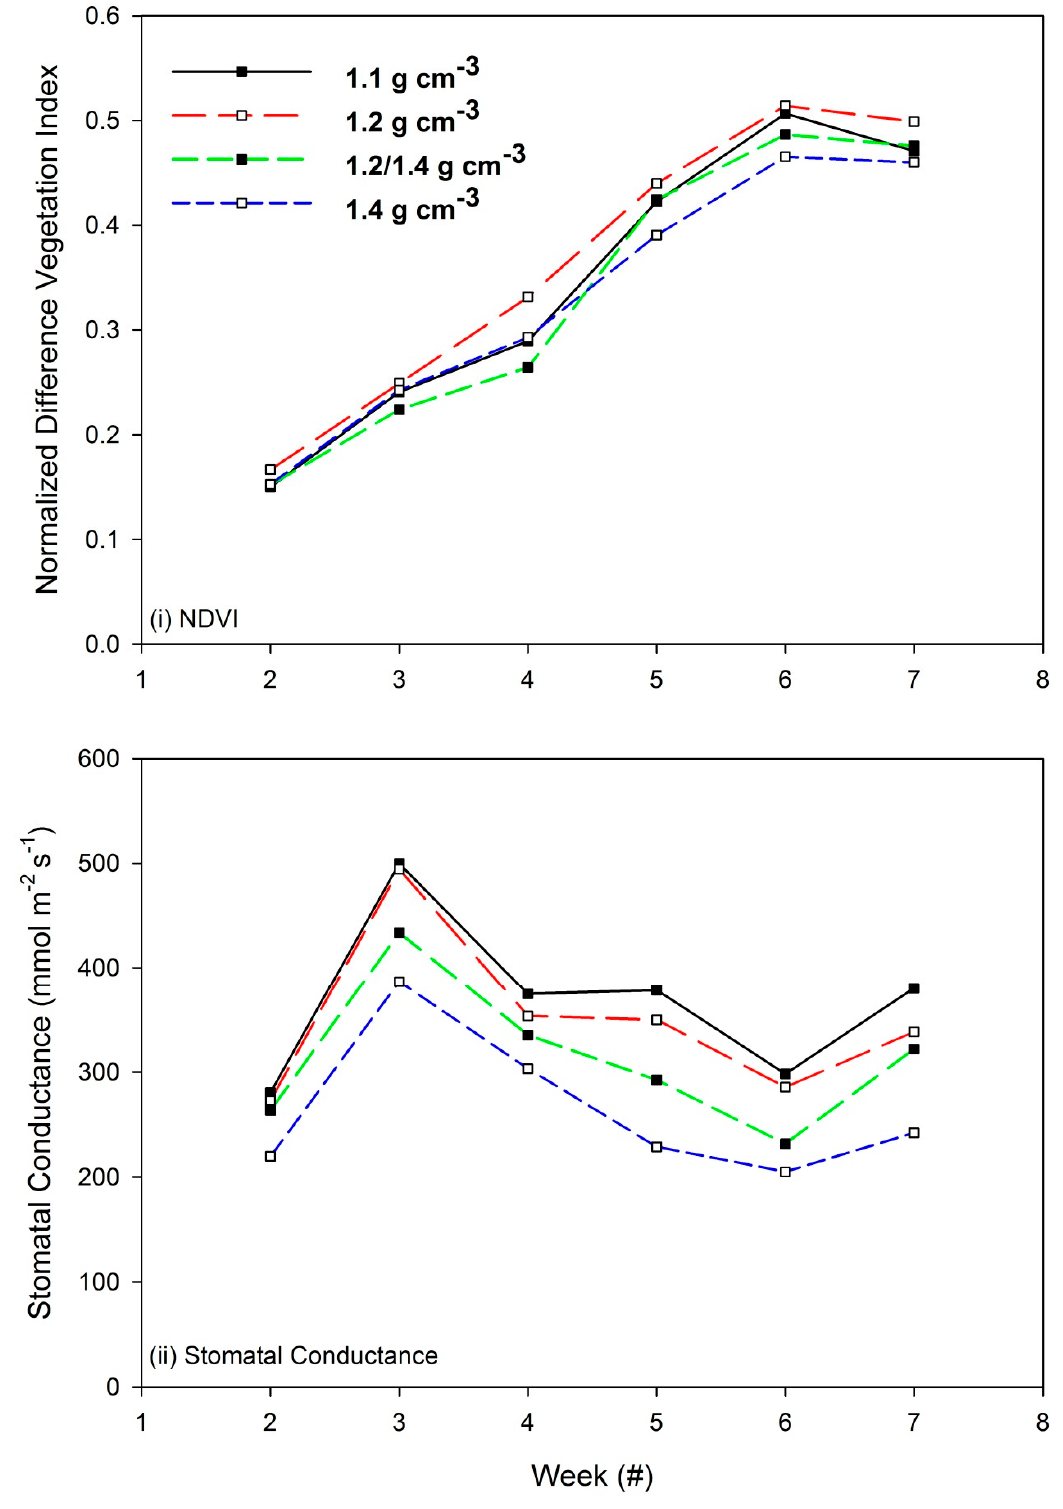
Figure 3. Temporal changes of ( i ) normalized difference vegetation index (NDVI) and ( ii ) stomatal conductance (g s ) per bulk density treatments. The changes on a weekly basis of the NDVI and stomatal conductance measurements for mean values of each treatment combination are displayed. In both panels, the bulk density of 1.2 g cm − 3 is shown to represent the most productive results, while the bulk density of 1.4 g cm − 3 displays the least.